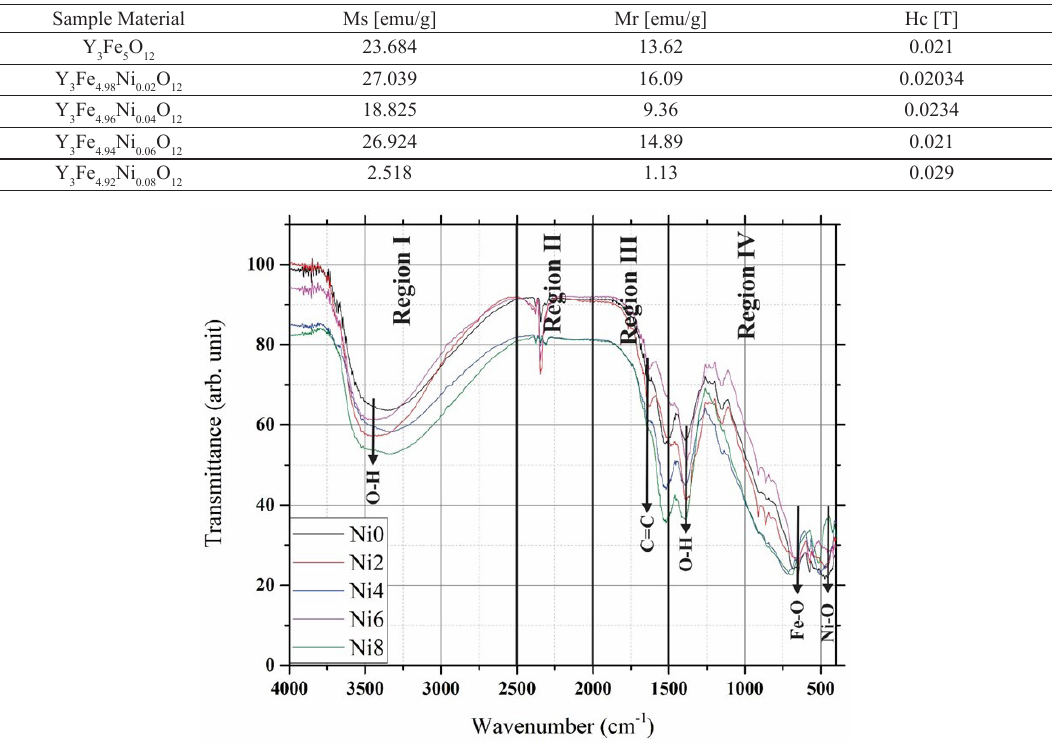
Figure 5. Molecular bonding of Yttrium Iron Nickel Garnet.